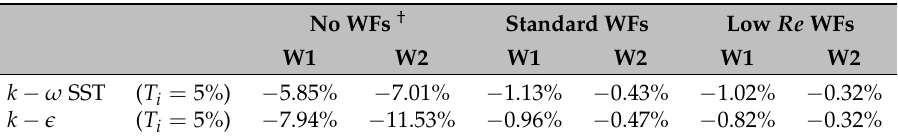
Figure 6. Screen shots of the spatial discretization around the two WEC structures ( a ) W1 and ( b ) W2. Table 2. Influence of wall function: nRMSD between the different viscous and inviscid flow simula- tions for controlled, heave-only, test